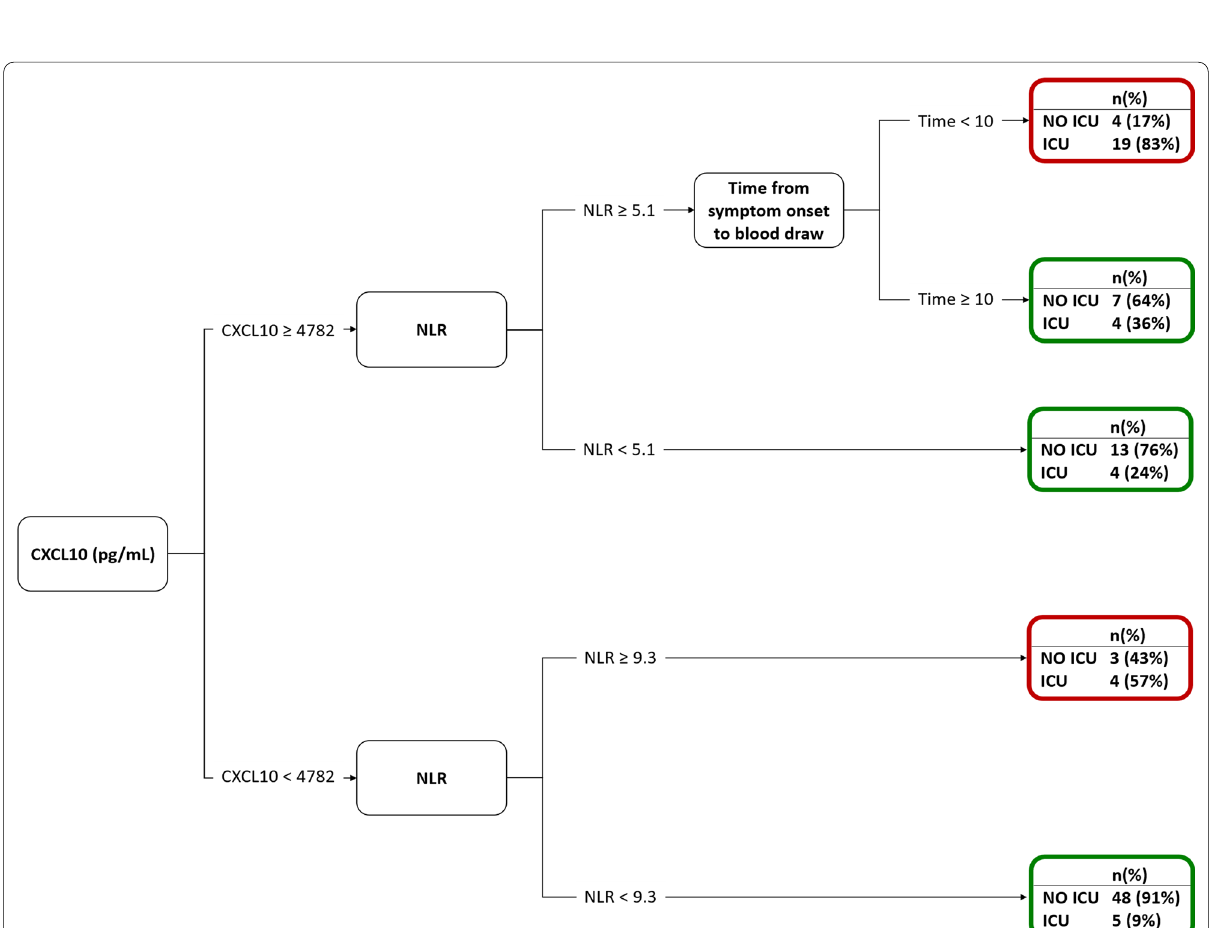
Fig. 2 Decision tree for the prediction of the ICU admission (AUC [95% CI]